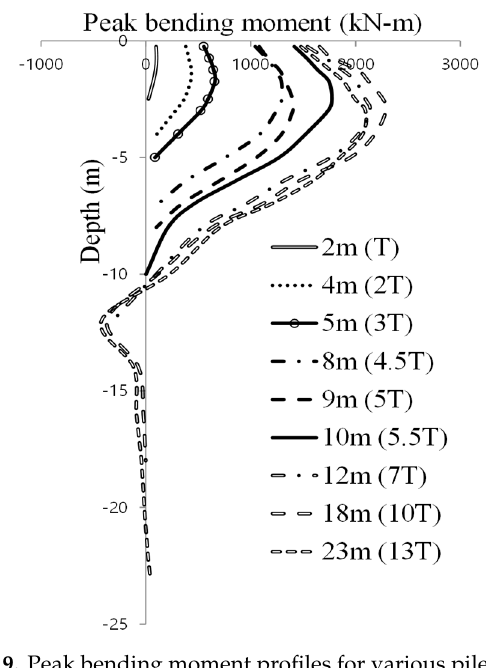
Figure 19. Peak bending moment profiles for various pile lengths.